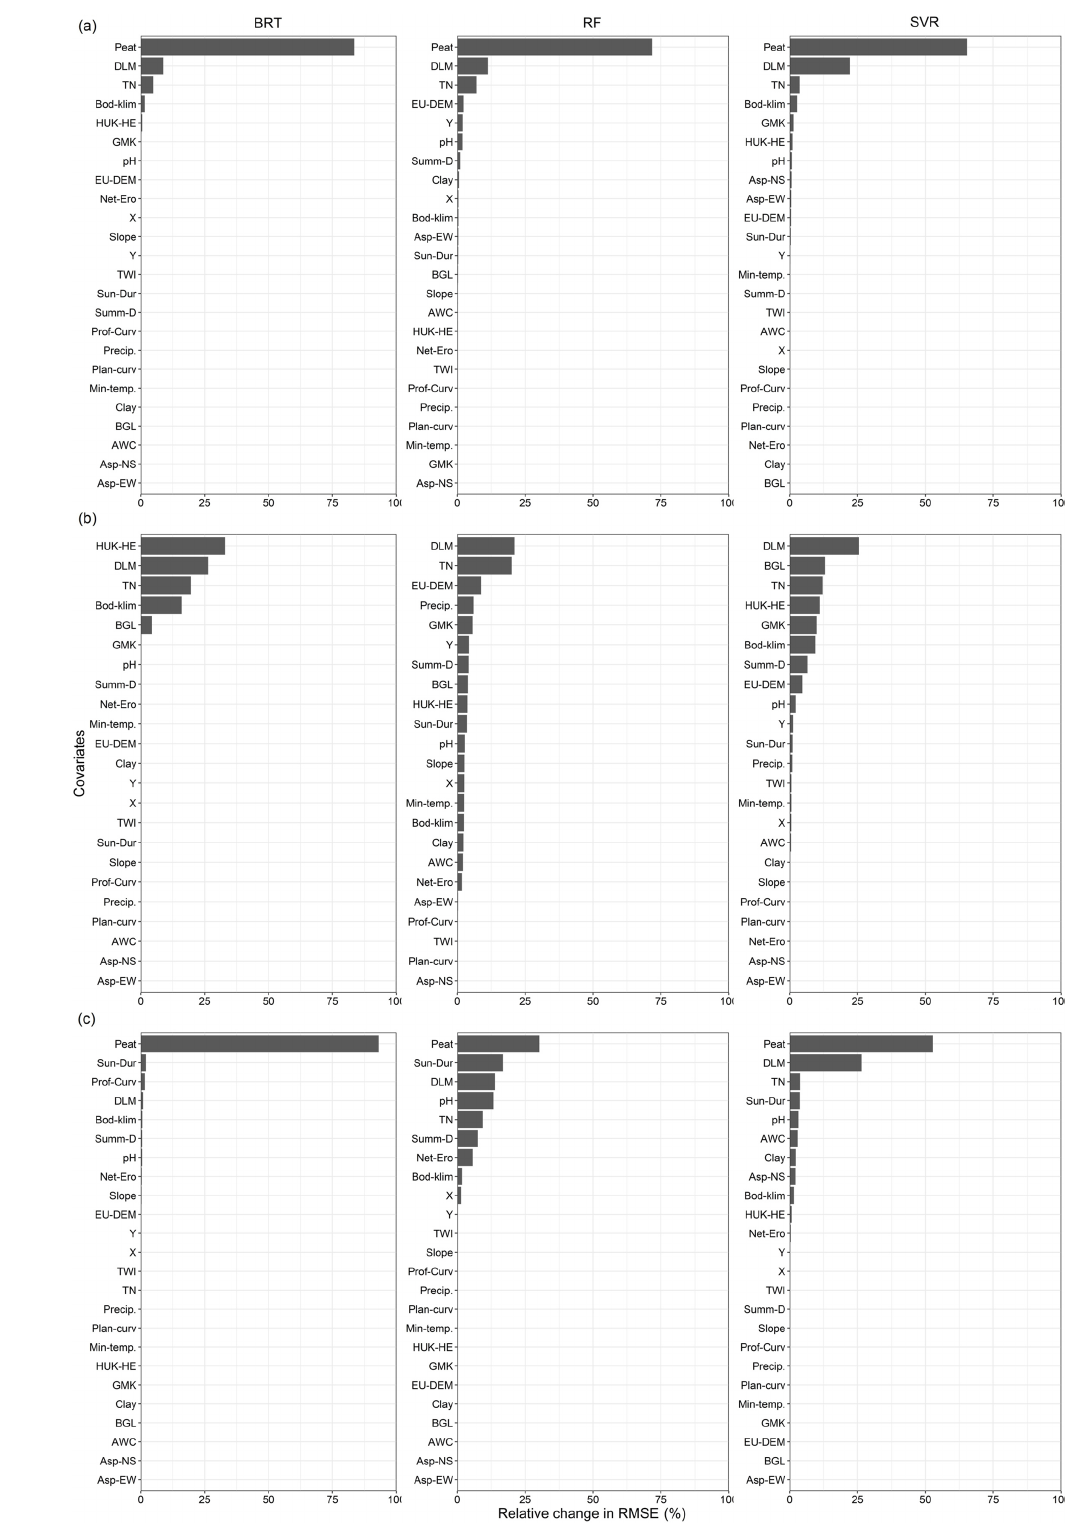
Figure 4. Variable importance in terms of average relative change (%) in RMSE for (a) AP1, (b) a mineral soil subset of AP2, and (c) an organic soil subset of AP2. The full name for each abbreviation on the y axis is presented in Table S4. The abbreviations used in the headings are as follows: BRT – boosted regression trees, RF – random forest, and SVR – support vector regression.